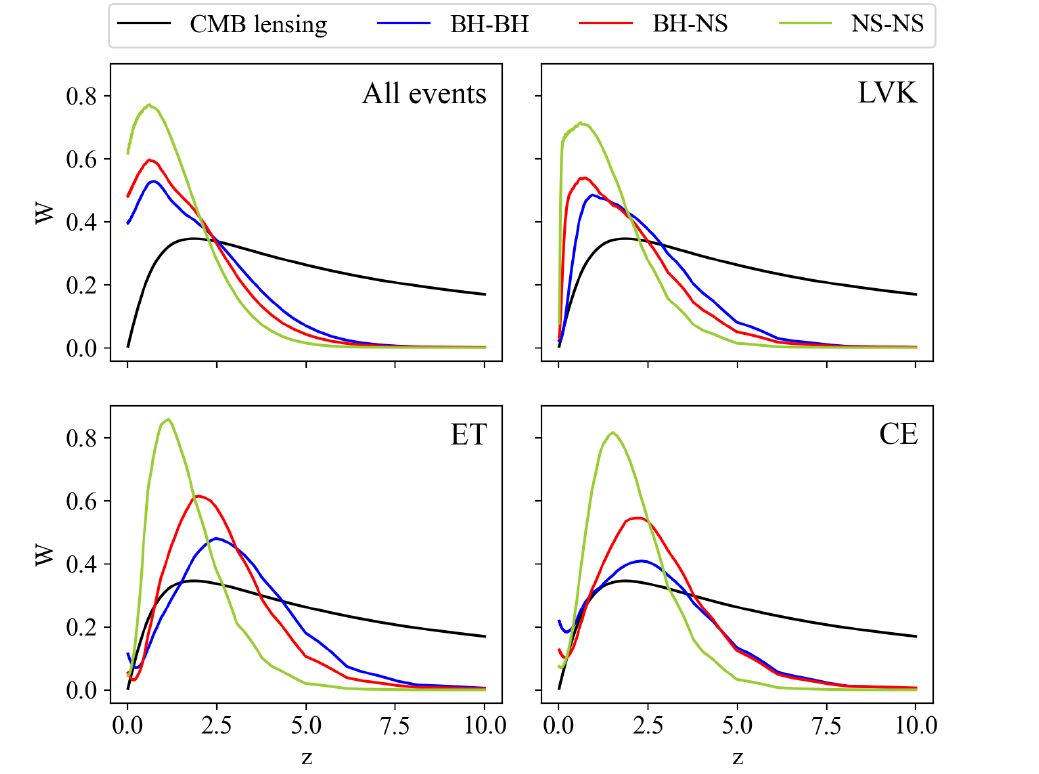
Figure 1. SGWB kernel W Ω ( z ) as a function of redshift for the three types of sources (BH-BH, BH-NS and NS-NS in blue, red and green respectively) at 65 Hz, compared with the lensing kernel W κ (in black). In the upper left panel we consider the SGWB given by the superposition of all GW events, resolved and unresolved. In the other three panels, instead, we consider the residual background obtained removing the GW events that are resolved by the considered detector (LIGO/Virgo/KAGRA, ET and CE